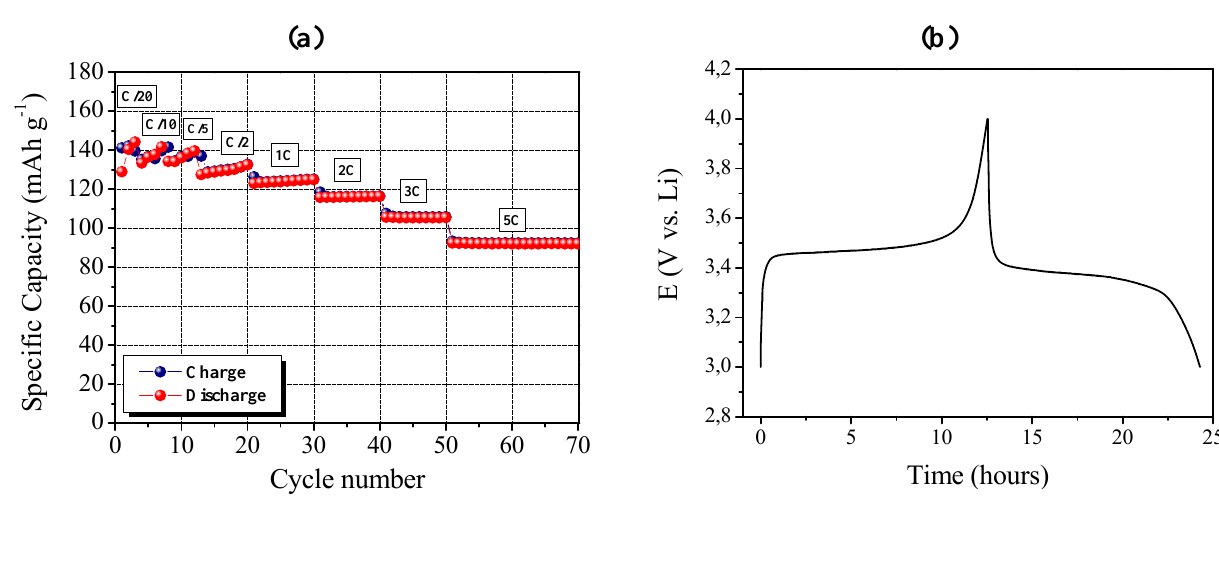
Figure 5. ( a ) Ambient temperature cycling performance of a LiFePO cell at different C-rates from C/20 to 5C (1C = 0.7 mA with respect to a LiFePO mass of about 4 mg); ( b ) Typical charge and discharge cycle run at ambient temperature.